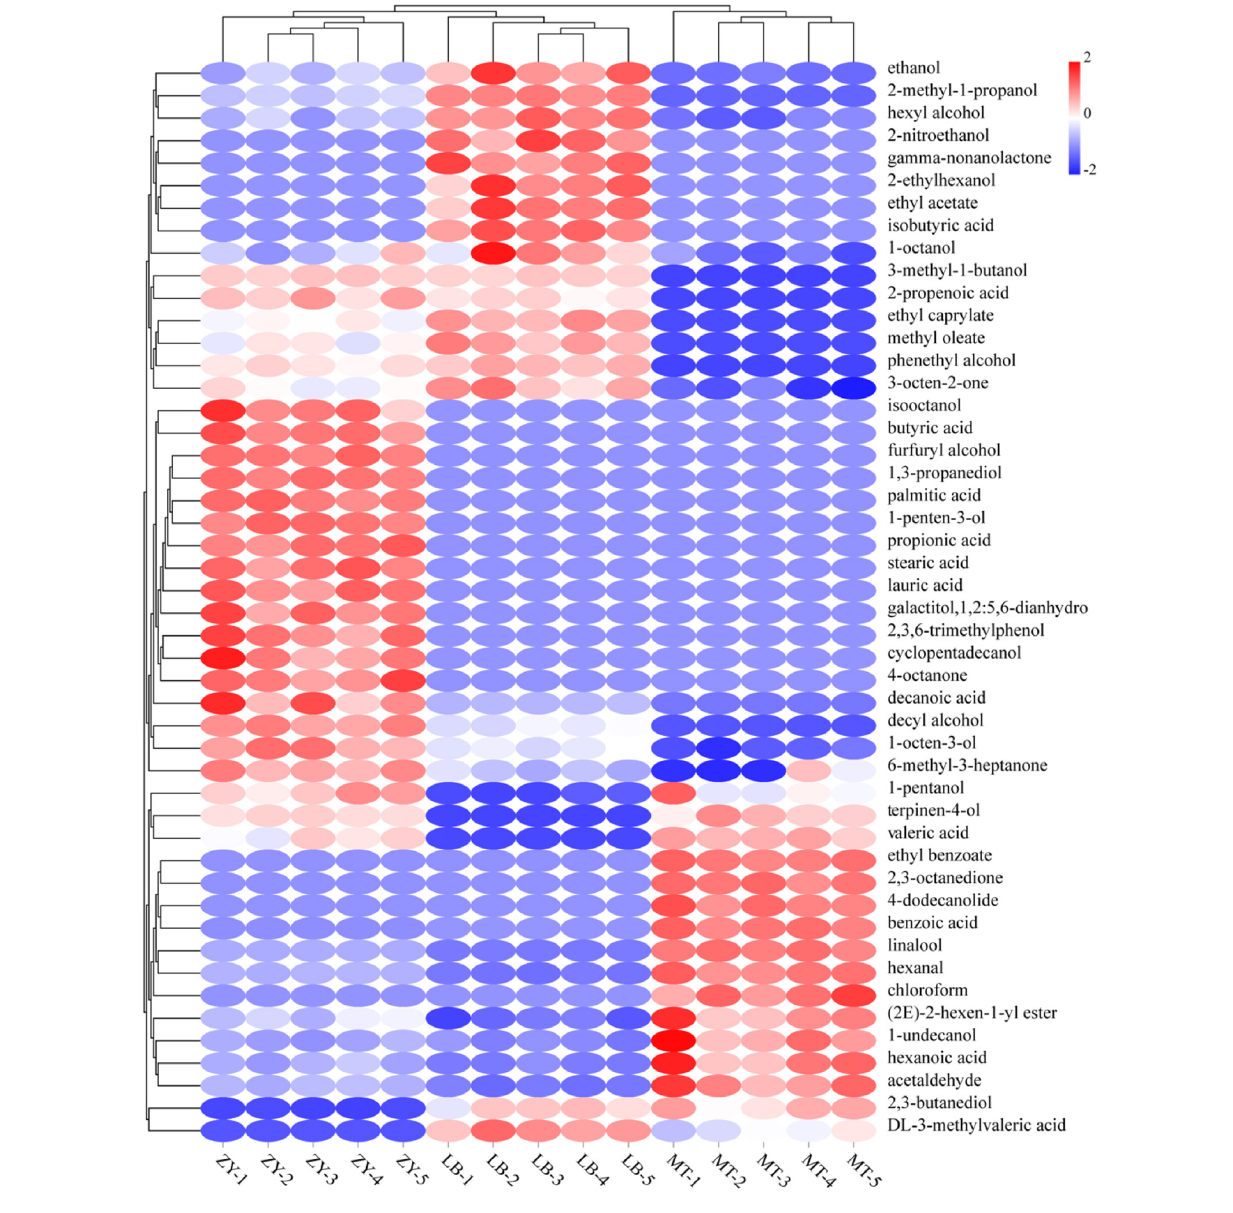
FIGURE 4 | Heat map of changes in differential compounds of SZR from three different